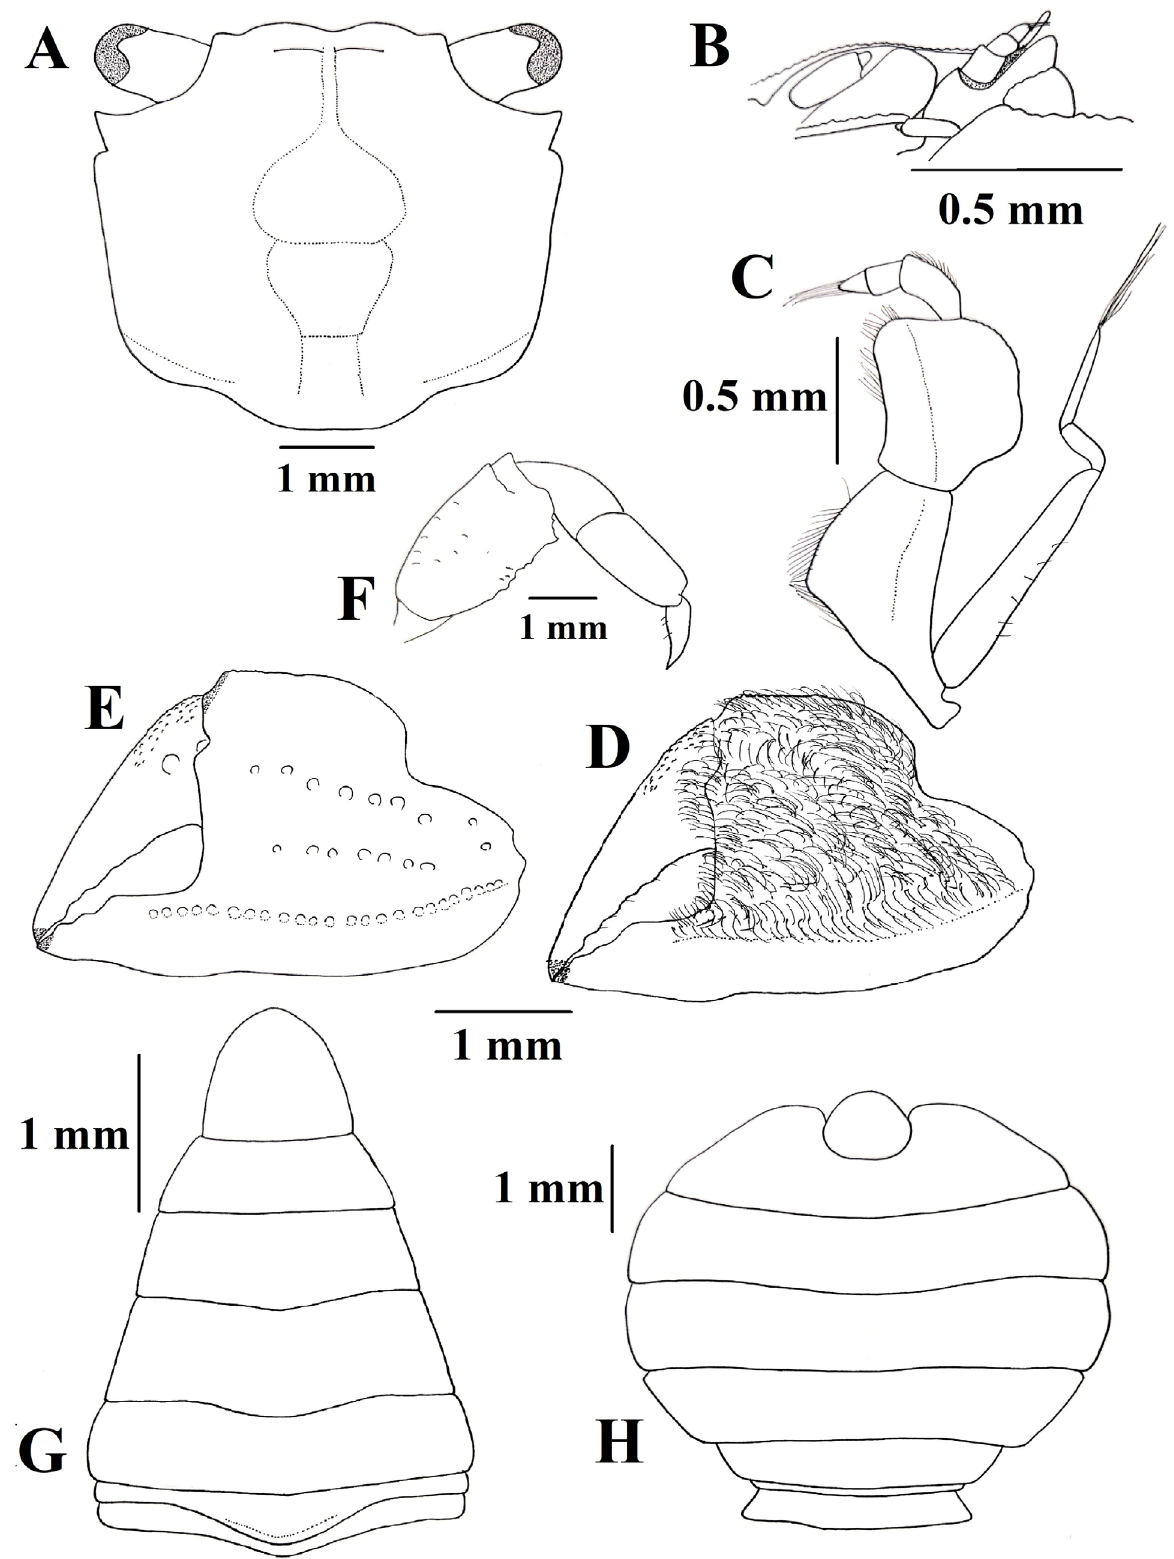
Figure 6. Nanosesarma jousseaumei (Nobili, 1906). A – F , Male (LFSC.ZRC-187) (CL: 4.8 mm; CW: 5.5 mm), Shivrajpur, Gujarat, India; G , female (LFSC.ZRC-187) (CL: 5.4 mm; CW: 6.2 mm), Shivrajpur, Gujarat, India. ( A ) Carapace; ( B ) basal antennular and antennal articles; ( C ) left third maxilliped; ( D ) palm of left cheliped (outer face with setae); ( E ) palm of left cheliped (outer face without setae); ( F ) right P5 (dorsal view); ( G ) male pleon; ( H ) female